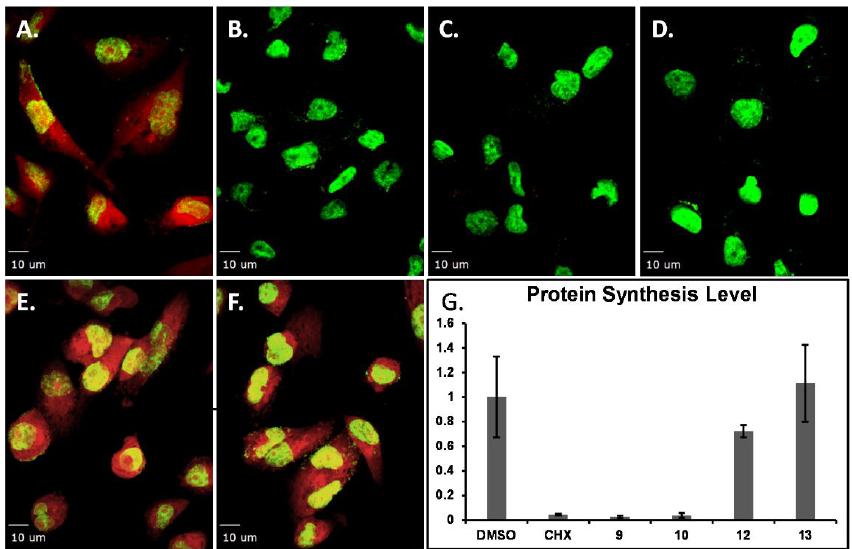
Figure 6. Representative images of protein synthesis inhibition EZClick ™ assay using MDA-MB-231 cellular model. Cells were treated with compounds for 1.5 h prior to click reaction followed by staining. A. Vehicle (DMSO). B. Positive control CHX (1 μ M). C. Compound 9 (5 μ M). D. Compound 10 (10 μ M). E. Compound 12 (10 μ M). F. Compound 13 (10 μ M). G. Relative quantification. Scale bar: 10 μ m.